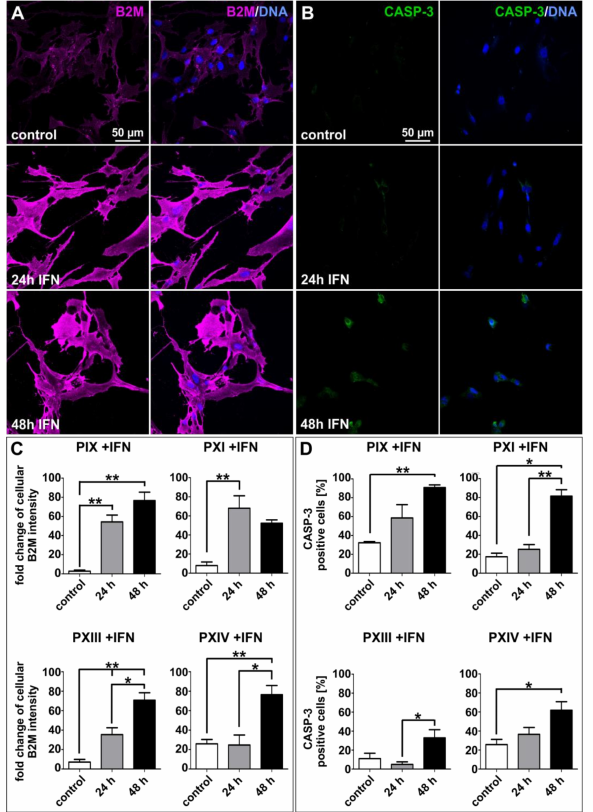
Figure 6. Interferon gamma treatment upregulated beta 2-microglobulin while only slightly inducing cleaved Caspase-3 in primary prostate cancer stem cells. ( A , B ) Exemplary immunocytochemical beta 2-microglobulin (B2M, A ) and apoptosis-related marker cleaved Caspase-3 (CASP-3, B ) stainings of control and the 24 or 48 h interferon gamma (IFN γ )-treated PXI PCSC population. ( C , D ) The effects of B2M immunostainings were statistically significant ( C ) but displayed only moderate IFN γ -related inductions of CASP-3 protein ( D ). Image quantification was performed using ImageJ software (NIH, Bethesda, MD, USA). Statistical analysis was performed with Mann–Whitney U tests (minimum 50 cells per analyzed protein, condition and population), * p ≤ 0.05 and ** p ≤ 0.01 were considered significant. Means are displayed as standard error of the mean